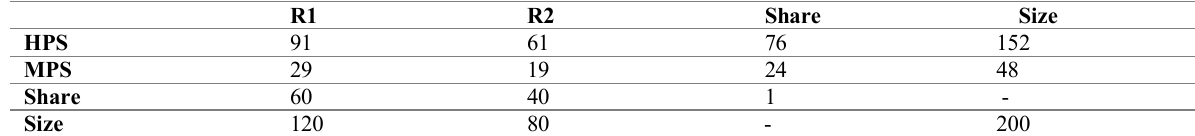
Table 3: Sampling Structure